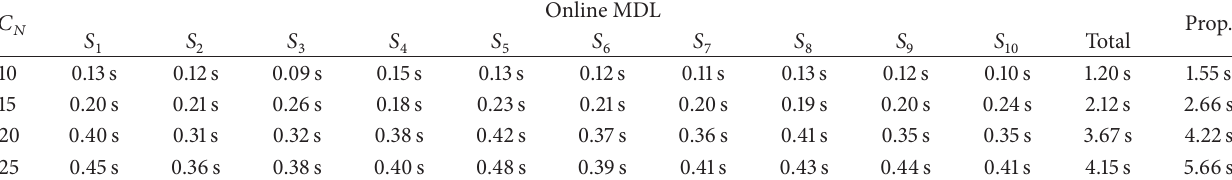
Table 6: Time cost of 10